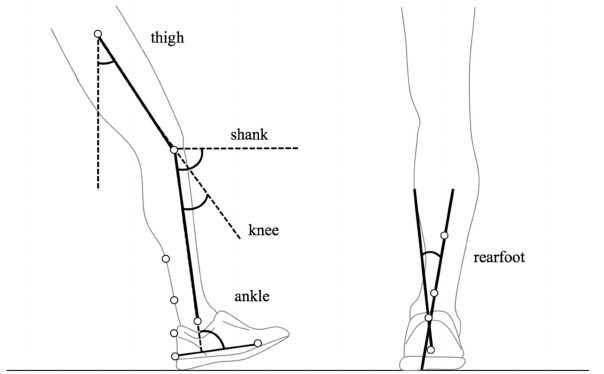
Figure 2. Kinematic markers setup model employed in the study. Forty-five stride cycles were approximately registered in each condition, and data processing was performed using Motive software (NaturalPoint, Inc., Corvallis, OR, USA). Marker data were filtered with a fourth-order low-pass Butterworth filter with a cut-off fre- quency of 6 Hz. A custom routine performed with the MatLab R2013b program (Mathworks Inc., Natick, MA, USA) was used to calculate running kinematics. The angle convention (Figure 2) was used to detect the movements of thigh and knee flexion–extension, shank oscillation, ankle dorsiflexion-plantar flexion and rearfoot eversion–inversion. Standing calibration of body segments was considered as zero degrees. Thus, positive values rep- resented hip flexion, knee flexion, greater shank oscillation, ankle plantar flexion and rearfoot inversion, while negative values described hip extension, knee extension, lower shank oscillation, ankle dorsiflexion and rearfoot eversion. Root mean square error (RMSE) was calculated to determine the 3D reconstruction accuracy, obtaining a systematic error of 0.005, 0.012 and 0.037 mm for X (mediolateral), Y (anteroposterior), and Z (vertical) axes,